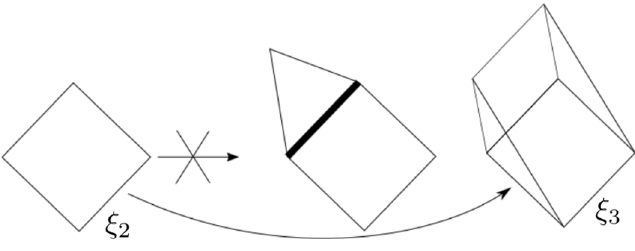
Figure 9 . Simple initial form with two distinct binomial factors corresponds to a 2d face (cid:24) 2 . Joining an extra edge to (cid:24) 2 will lead to (cid:24) 3 . Since the simplicity relation is preserved, it increases the dimension by one. The con(cid:12)guration in the middle does not preserve this relation, therefore is not simple. For the middle picture, the bold edge of (cid:24) 2 is not an edge of the resulting convex hull. init ( (cid:24) ) would have two distinct binomial factors. Conversely, for any initial form with two binomial factors, these factors cannot belong to the same edge | the initial form is said to be simple. The only monomials are vertices of its convex hull (in the opposite situation we would encounter some monomials which are not the vertices | a